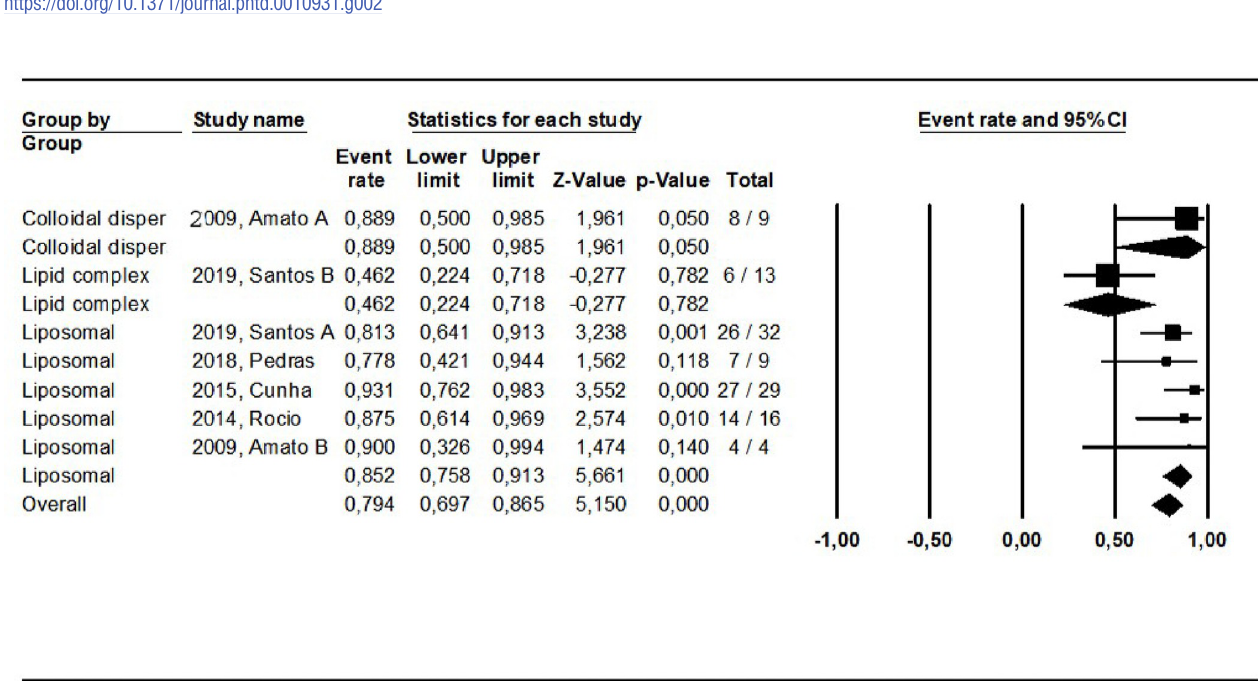
PLOS NeglectedTropical Diseases | https://doi.org/10.1371/journal.pntd.0010931 November17, 2022 20 /